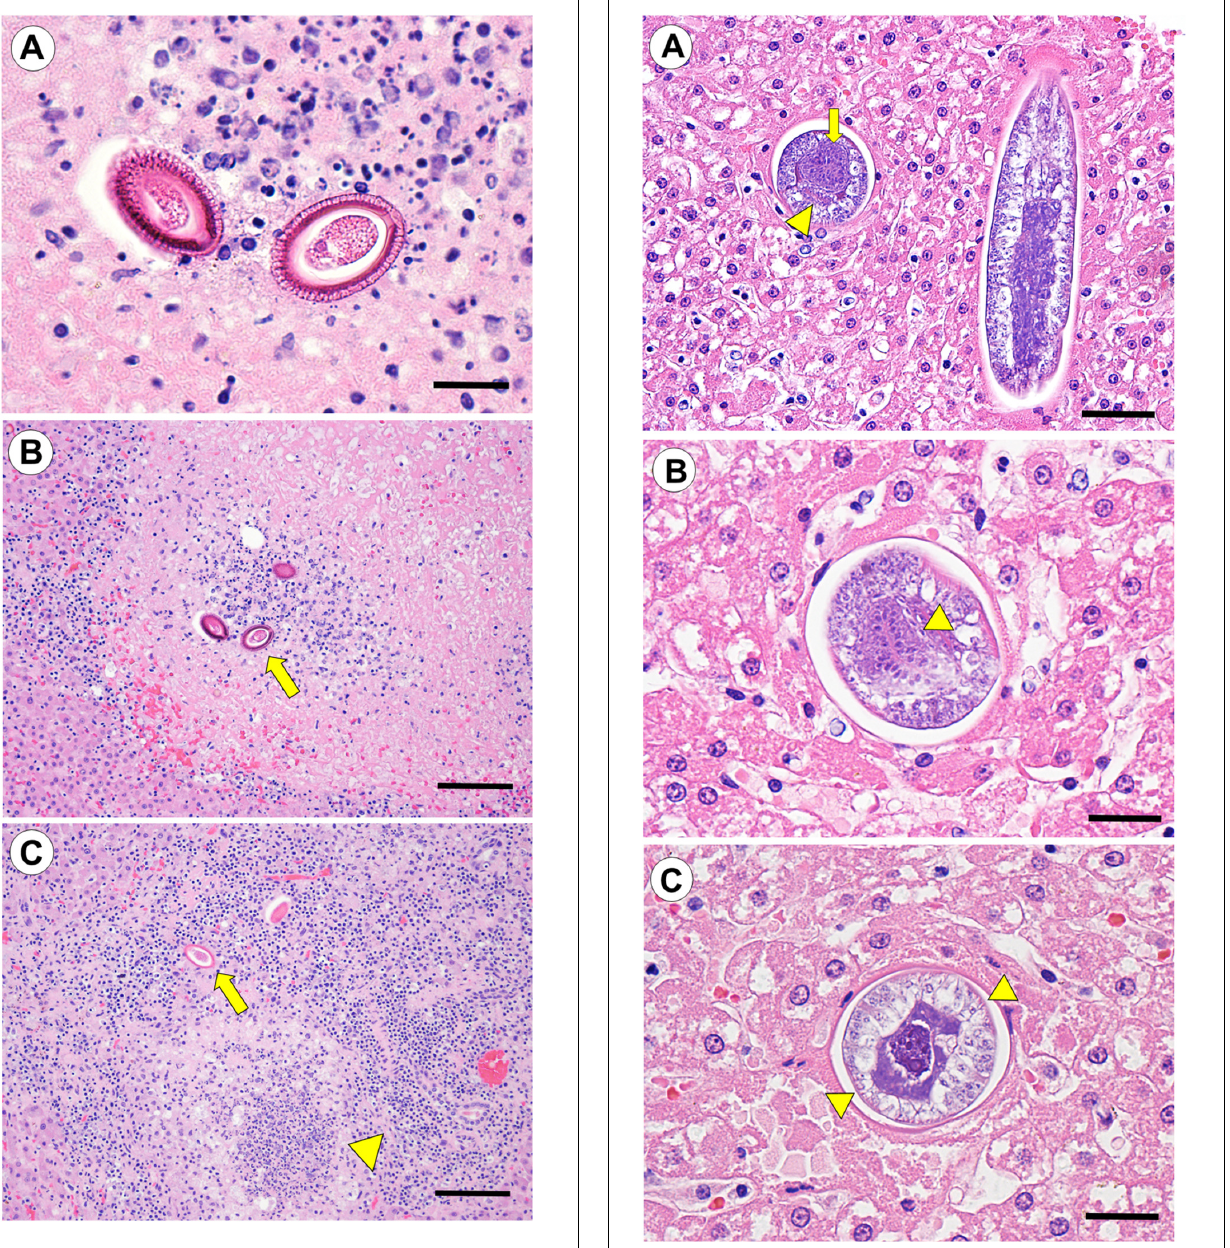
FIGURE 2 | (Case 2): Hepatic capillariasis in a southern sea otter ( Enhydra lutris nereis ) that died from shark bite with secondary bacterial infection. (A) Microscopic examination of hepatic parenchyma subjacent to grossly apparent hepatic fibrinous to fibrous capsular plaques revealed multifocal clusters of large (90–100 × 45–55 µ m), non-pigmented, un-embryonated, barrel-shaped parasite eggs similar to those described for Case 1 above (hematoxylin and eosin stain. Bar = 50 µ m). (B) Lower magnification view of the same parasite eggs shown in (A) : the parasite eggs were arranged in discrete masses, and were surrounded by areas of coagulation necrosis, hemorrhage, inflammation, and fibrous connective tissue (hematoxylin and eosin stain. Bar = 200 µ m). (C) Small circular, linear, or serpiginous bands of hepatic cavitation with perilesional granulomatous inflammation were suggestive of parasite migration tracks (arrowhead). Parasite eggs were often located along the outer edge of the cavitated lesions (broad arrow) (hematoxylin and eosin stain. Bar = 200 µ m).